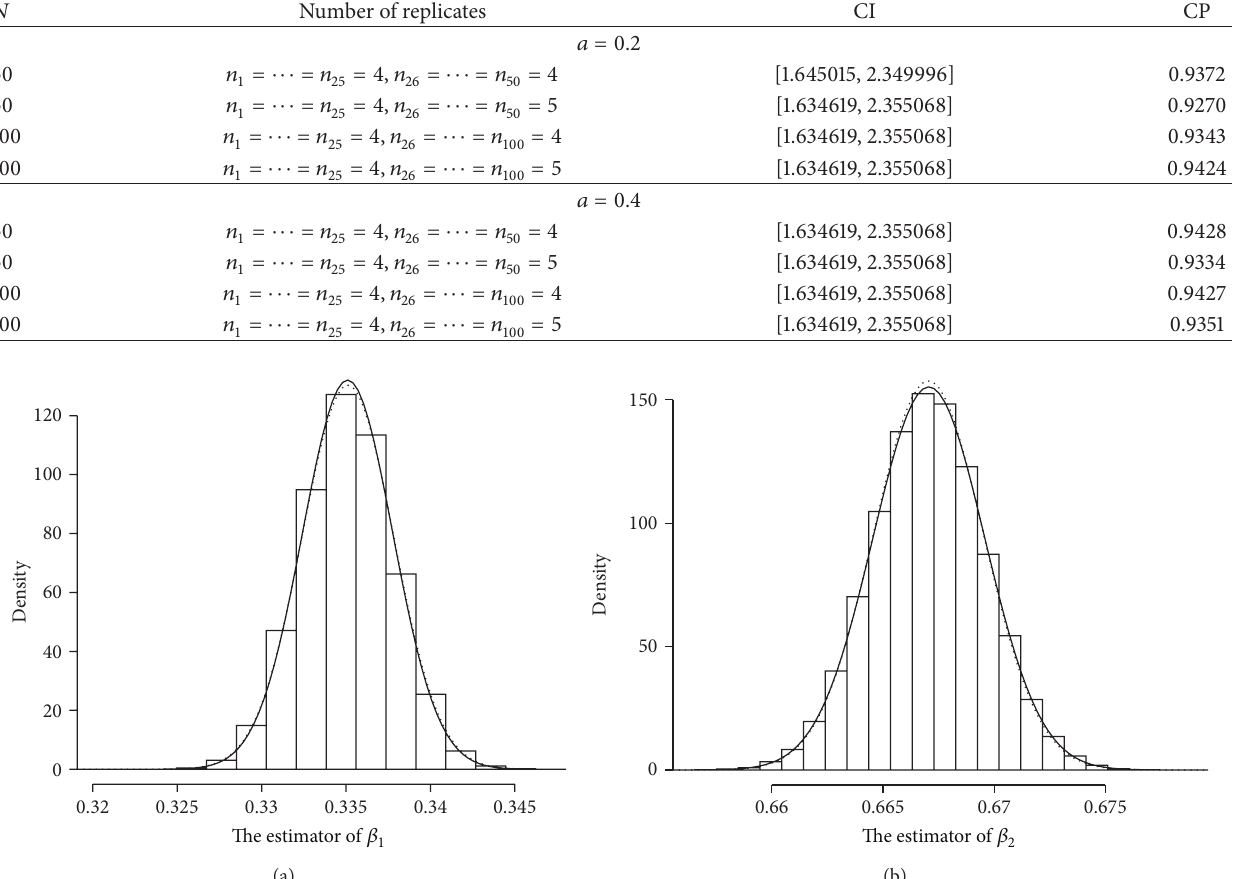
Table 1: The selection probabilities of adaptive EL shrinkage estimation.